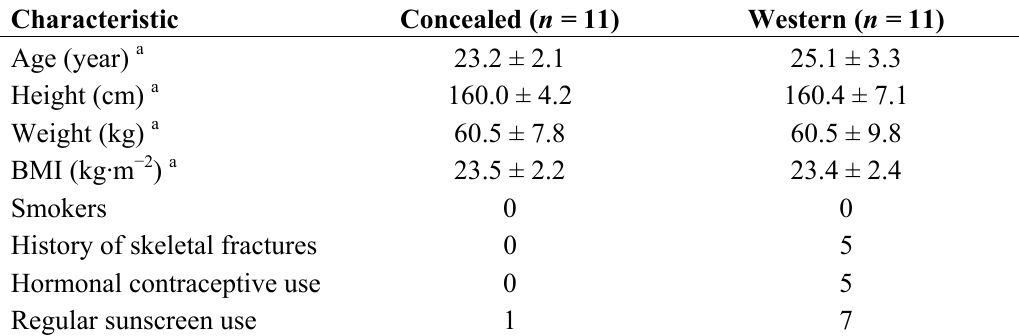
Table 1. Subject characteristics of women who wore concealing versus western-style